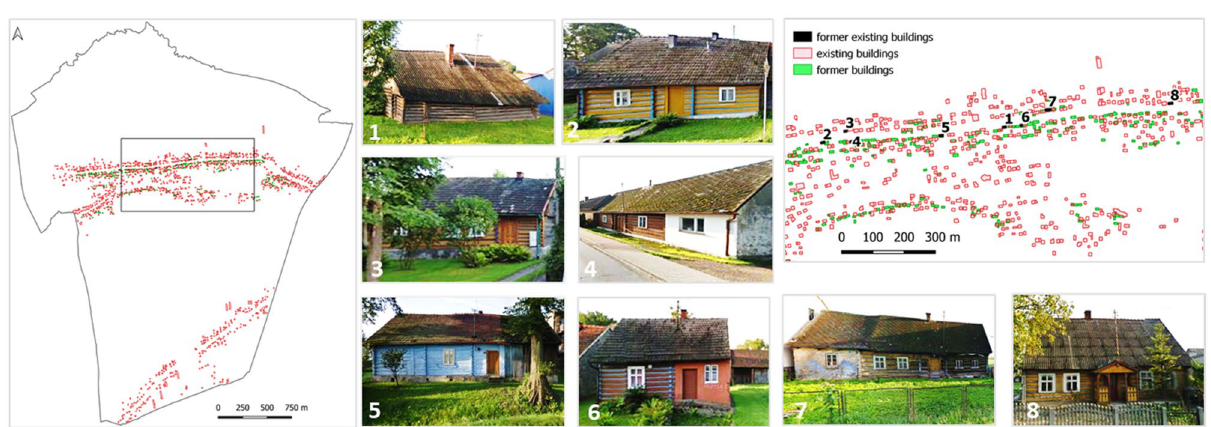
Figure 8. Analysis of historical and modern development overlap; identification of historical objects with examples of historical buildings in Kaszów identified using land structure persistence